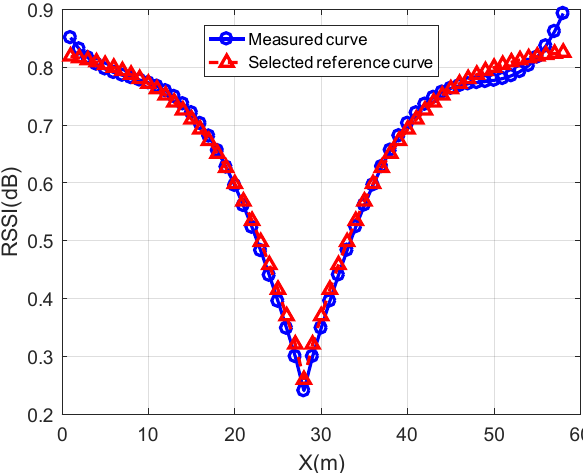
Figure 14. Comparison of curves after data